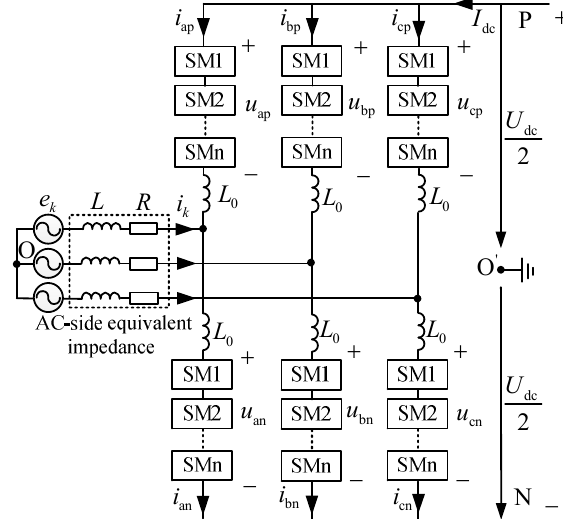
Figure 1. Topology of three-phase modular multilevel converter (MMC).